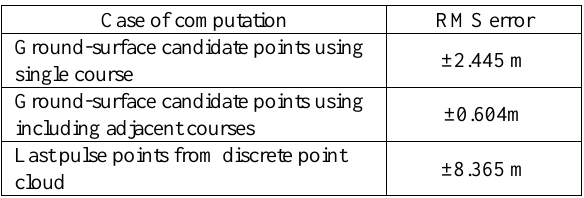
Table 2. RMS error for 10